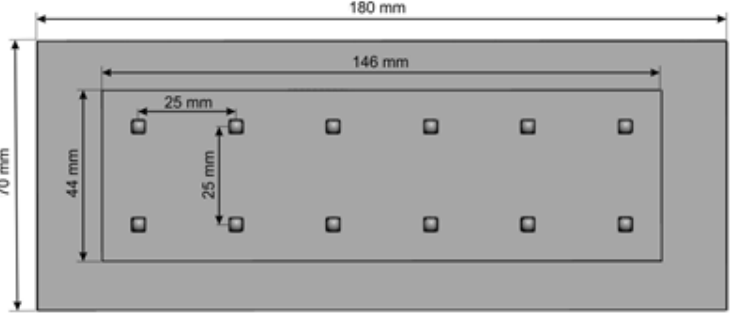
Figure 2. Model of the studied light-emitting diode (LED) panel.